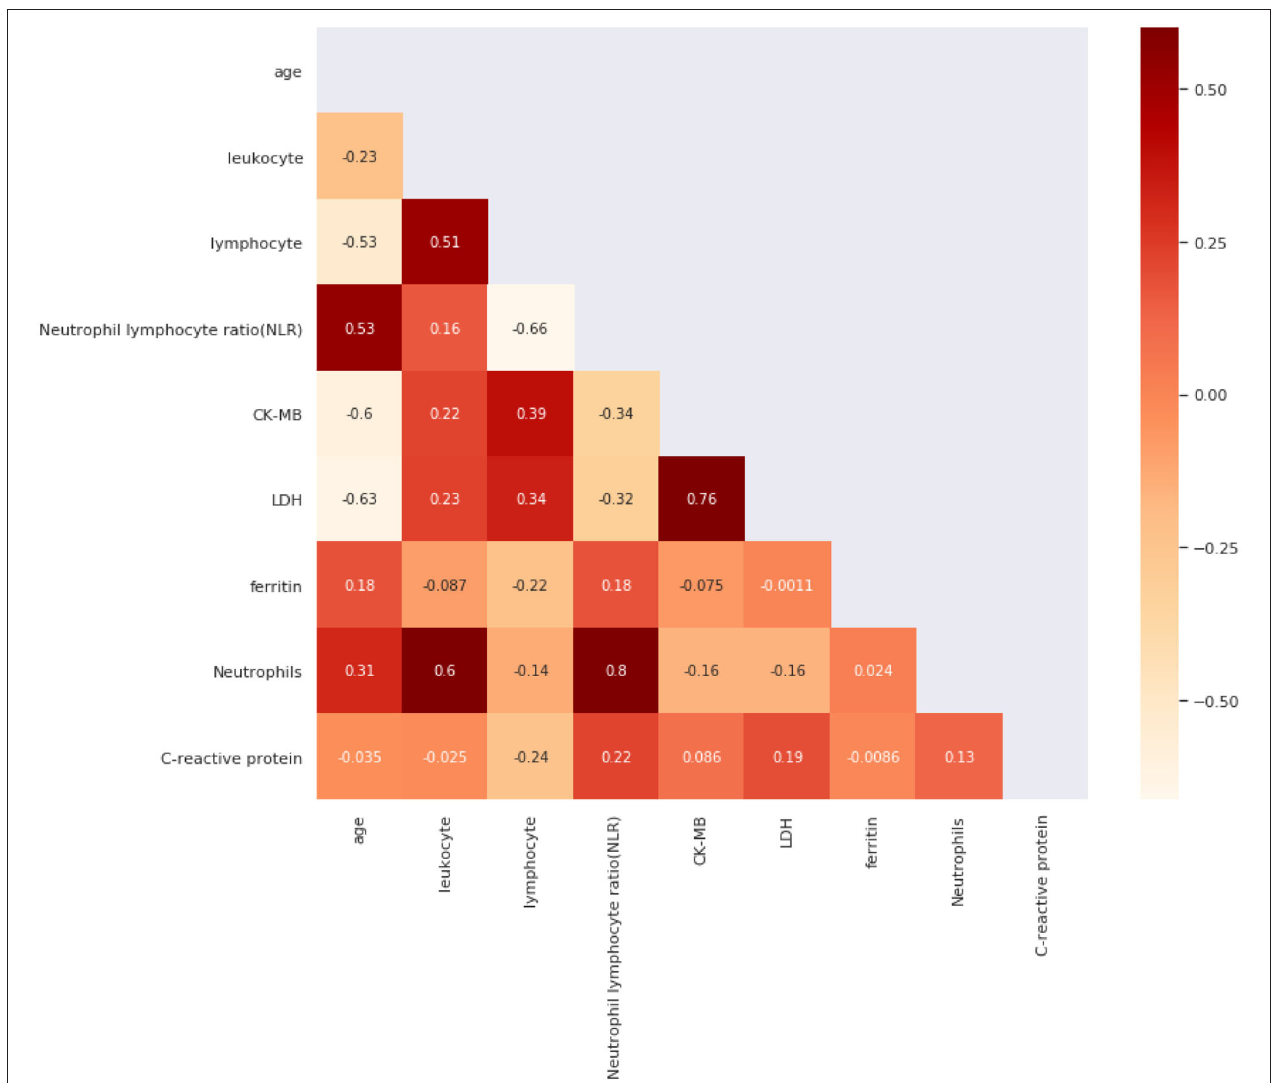
FIGURE 2 | Spearman’s Correlation for all features.